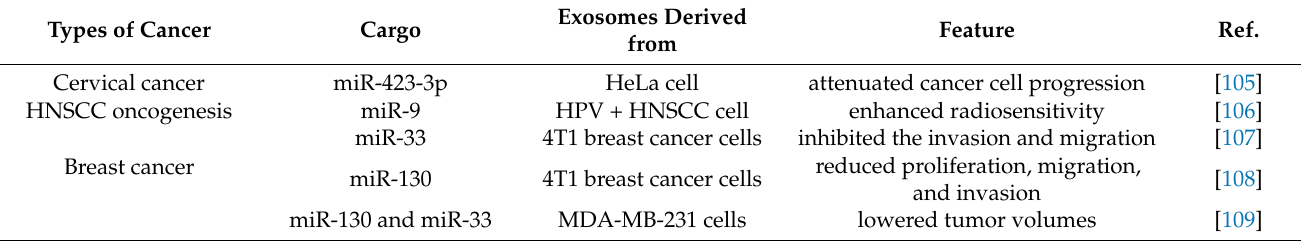
Table 2. Exosomal molecules responsible for anti-cancer effects via macrophage polarization. Exosomes Derived Feature Types of Cancer Cargo from